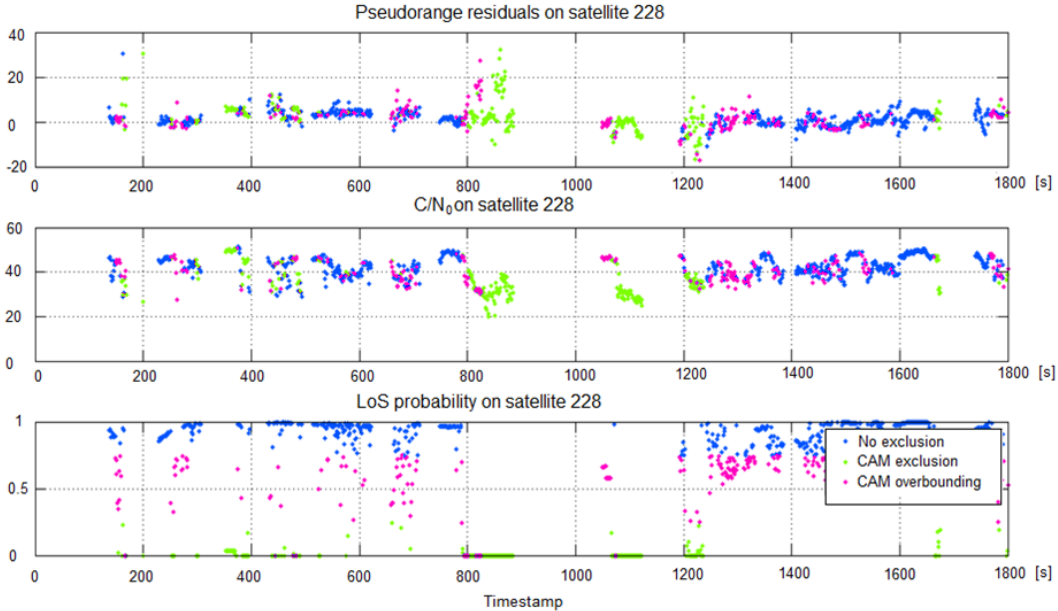
Figure 10. Pseudorange residuals, C/N 0 and LoS probability on SVID GPS 28.